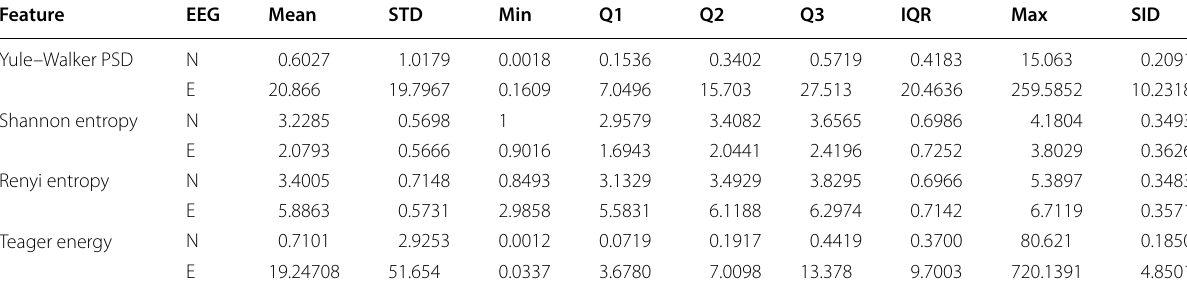
Table 2 Descriptive analysis of extracted